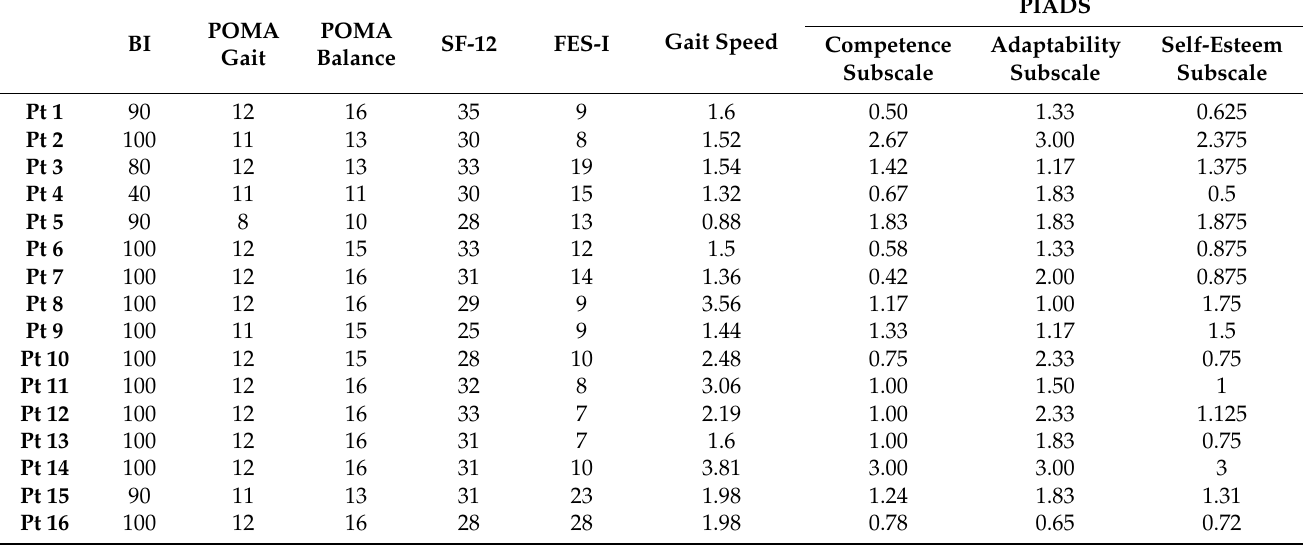
Table A3. Post-intervention score of the BI, POMA gait and Balance, SF-12, FES-I, Gait